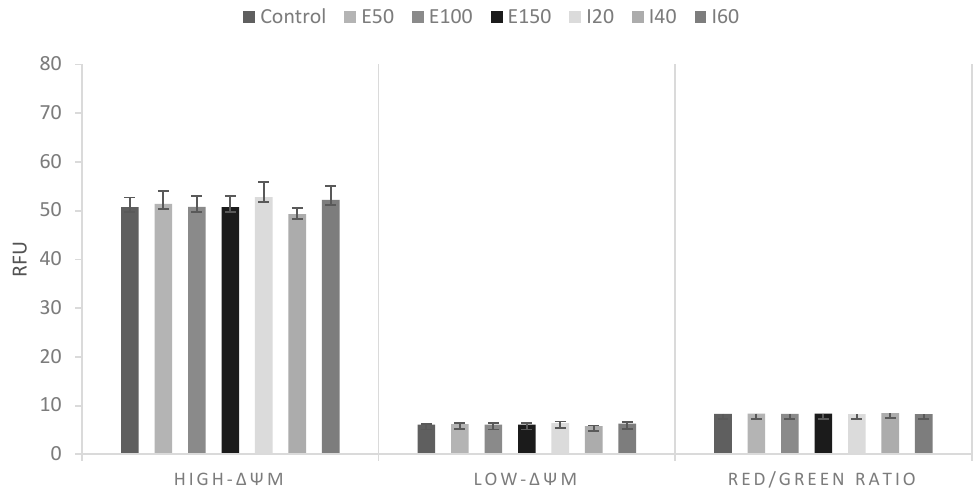
Figure 2. Mitochondrial membrane potential of frozen-thawed canine semen. E50: ergothioneine at 50 µM. E100: ergothioneine at 100 µM. E150: ergothioneine at 150 µM. I20: isoespintanol at 20 µM. I40: isoespintanol at 40 µM. I60: isoespintanol at 60 µM. Low- ΔΨ M: low mitochondrial membrane potential. High- ΔΨ M: high mitochondrial membrane potential. RFU: relative fluorescence units. Bars represent the mean ± standard error of the mean (SEM). No significant statistical differences were found ( p ≥ 0.05).